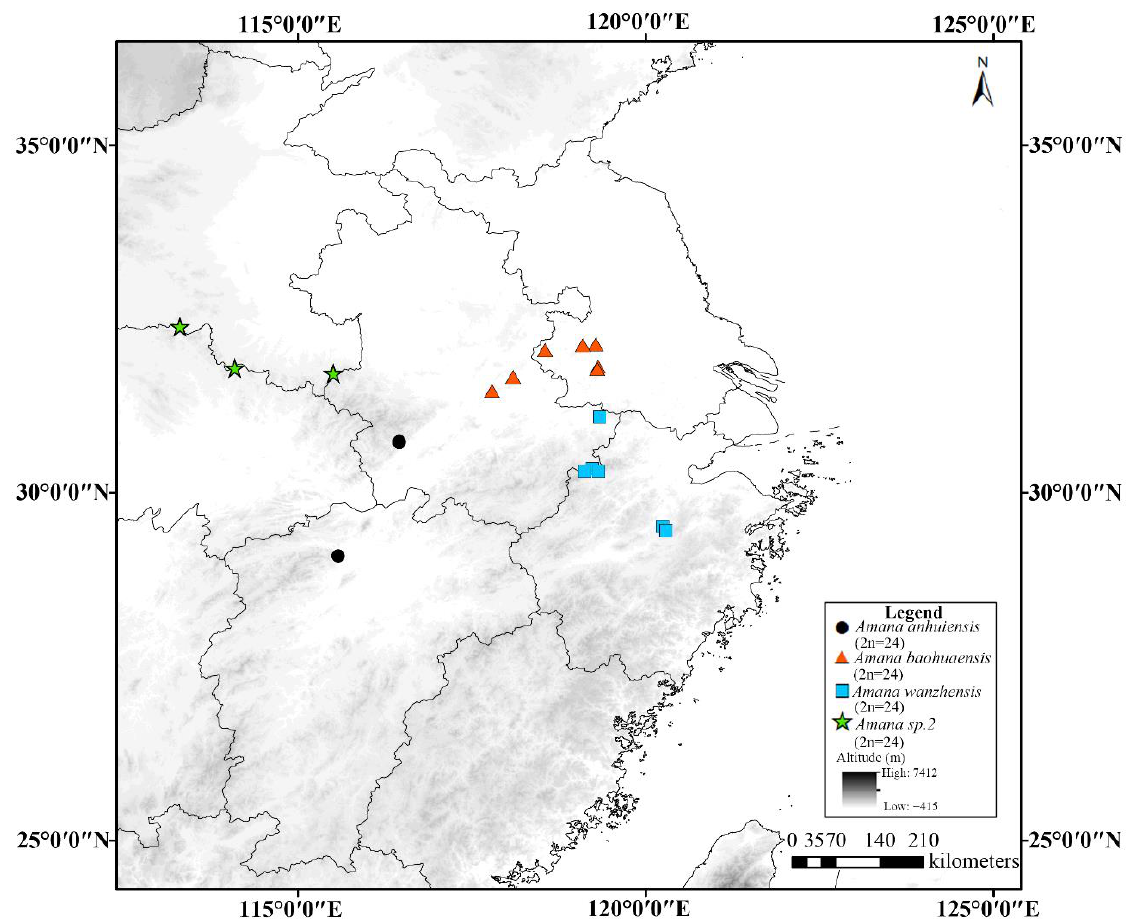
Figure 5. Distribution of ploidy levels of Amana anhuiensis , A. baohuaensis , A. wanzhensis and Amana sp.2 in Hubei, Henan, Jiangxi, Anhui, Jiangsu and Zhejiang provinces. All four species are diploid (2 n = 2 x = 24).